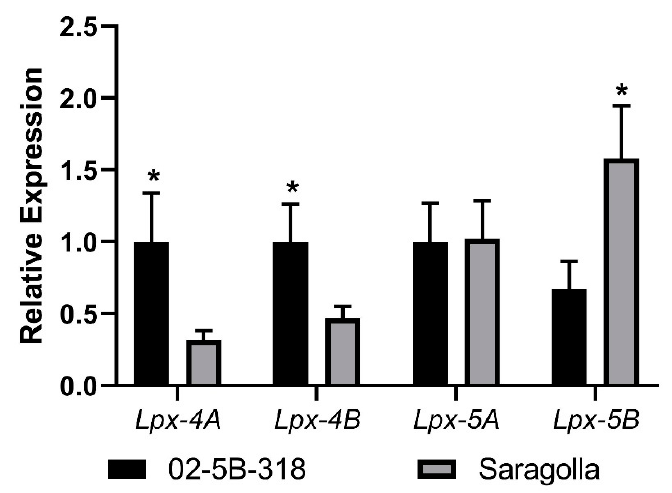
Figure 1. Lipoxygenase ( Lpx ) gene expression on leaves. qPCR was performed on the Lpx genes mapped on chromosomes 4A, 4B, 5A, and 5B in leaves of the bread wheat accession “02-5B-318” (low YI) and the durum wheat cv. “Saragolla” (high YI). ANOVA and Fisher’s least significant di ff erence (LSD) tests were used to underline significant di ff erences between the genotypes, * p < 0.05.